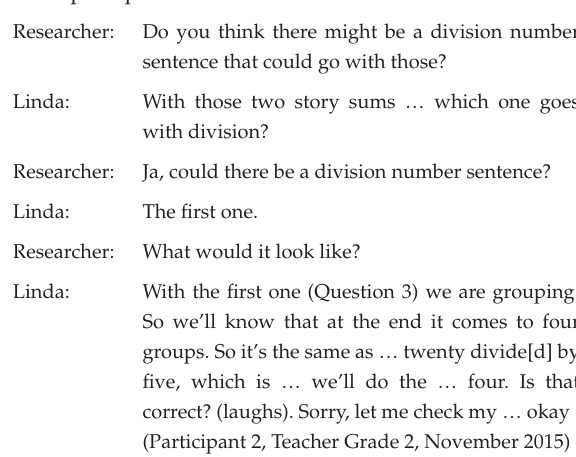
Teacher Linda´s drawing for Ques(cid:12)on 3 (Tom has 20 crayons.